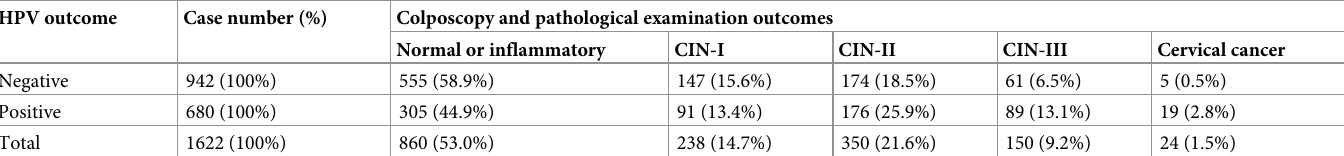
Table 3. Analysis of HPV testing outcomes and pathological examination outcomes for 1622 patients with cervical lesions. HPV